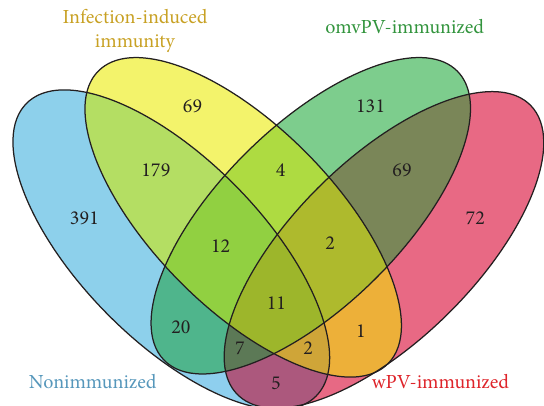
Figure 2: Venn diagram. The overlap of differentially expressed genes between four datasets obtained from lungs of mice at different time points after B. pertussis challenge is